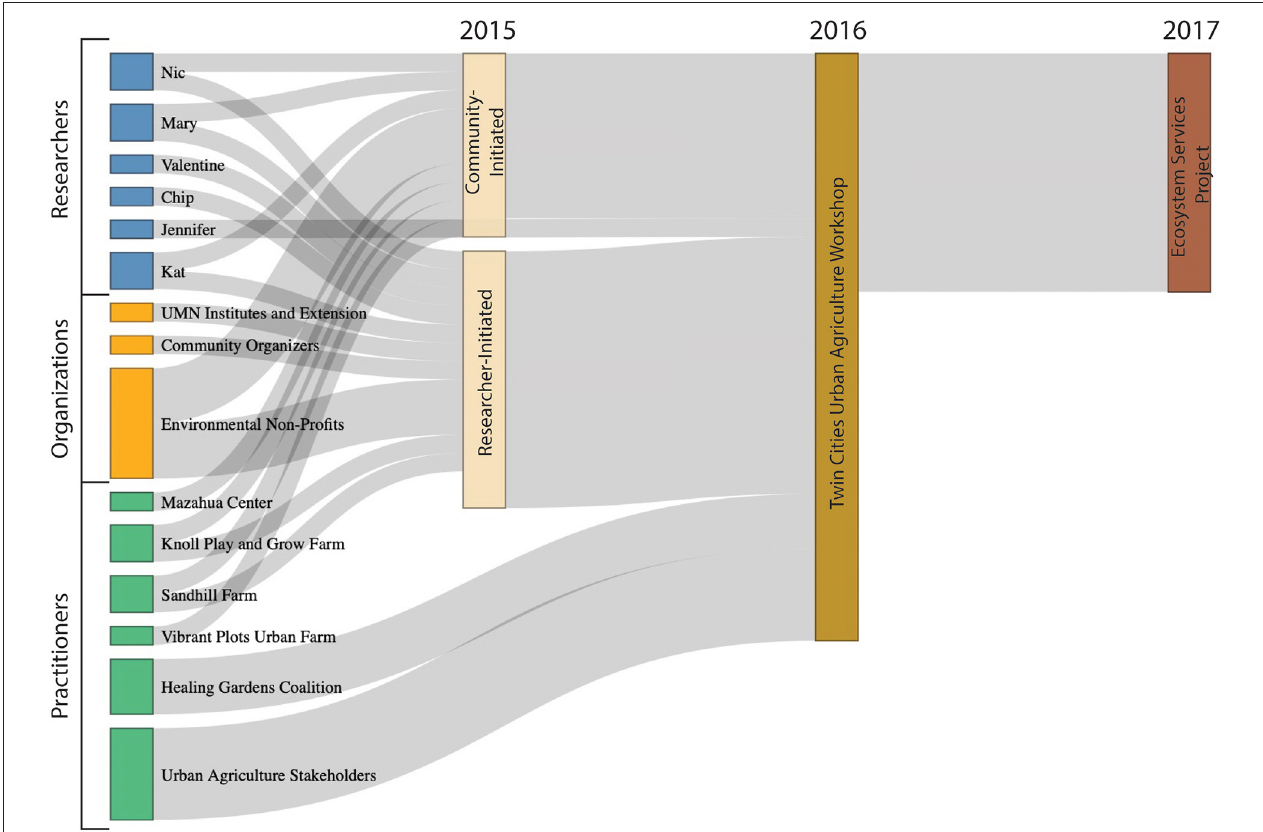
FIGURE 1 | MSP Urban Agroecology Community-University Partnership Development. The progression of our research program from the initial conversations and pilot studies in 2015 to the start of the current projects in 2017. At the University of Minnesota Convergence Colloquium on Sustainable Foods in 2015, a group of 20 researchers, organizers, and practitioners connected and pursued a 1 year, researcher-initiated project to host conversations and engagement activities around the ecosystem services of urban farms and gardens. At the same time, a community-initiated project convened three researchers, several non-profits, and four growers to do an on-farm pilot study exploring the potential for urban food production as a green infrastructure strategy. The projects converged by collaboratively hosting the Urban Agriculture Research Workshop, which was attended by over 70 urban growers, organizers, policymakers, and researchers. Some attending this workshop would eventually join the ecosystem services project. After the workshop, some partners from the community- and researcher-initiated projects left to pursue other priorities or other participatory projects, and a smaller group continued working together for the current ecosystem services